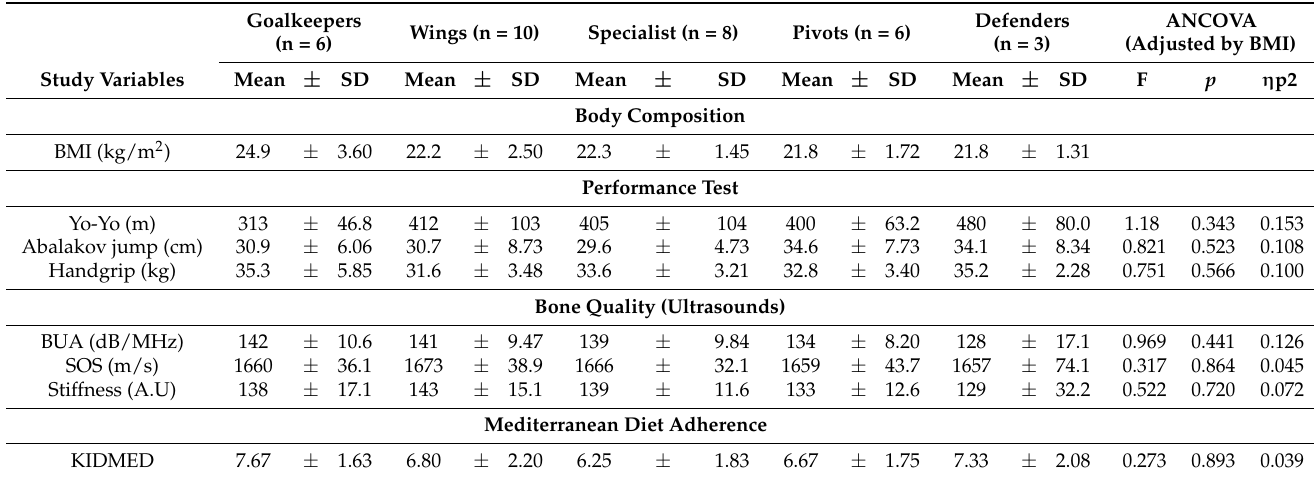
Table 3. Position-related differences in variables.